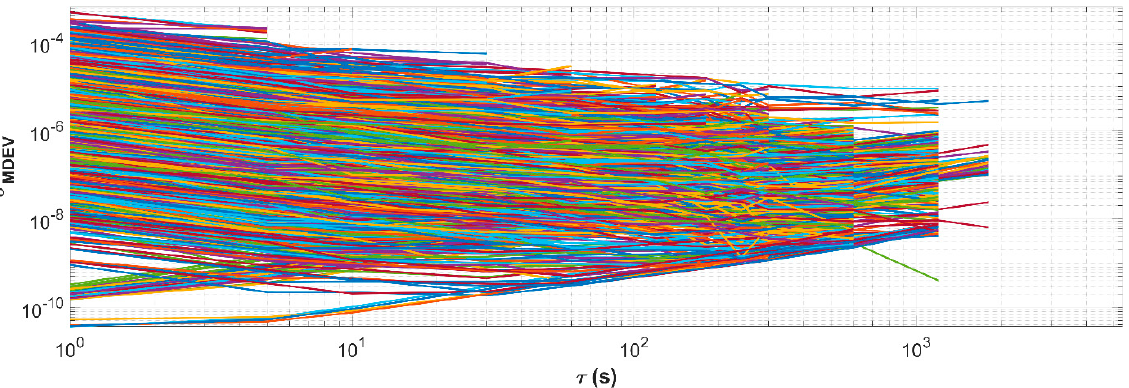
Figure 2. MDEV of the estimated clocks of all 17 CubeSats from the RD-POD over the testing period (31 days: 16 Dec 2020–15 Jan 2021). Different colours are dedicated to the different observation seg- ments.